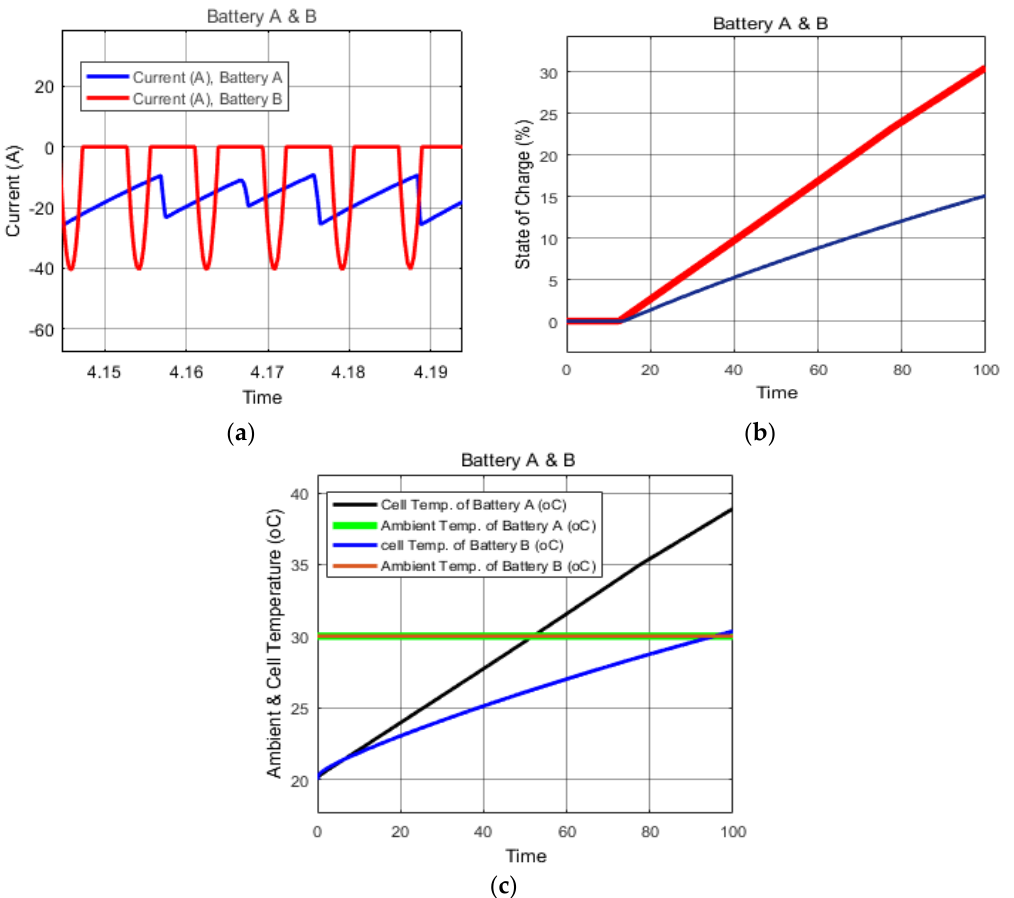
Figure 5. Results of ACM technique implemented along with CT–CV method on battery A. The voltage ( a ) of battery A is 10 V, and that of battery B is 8.2 V. The state of charge ( b ) reaches up to 30% in the ACM method and 15% in reference battery with temperature rises ( c ) of 38 °C and 30 °C.